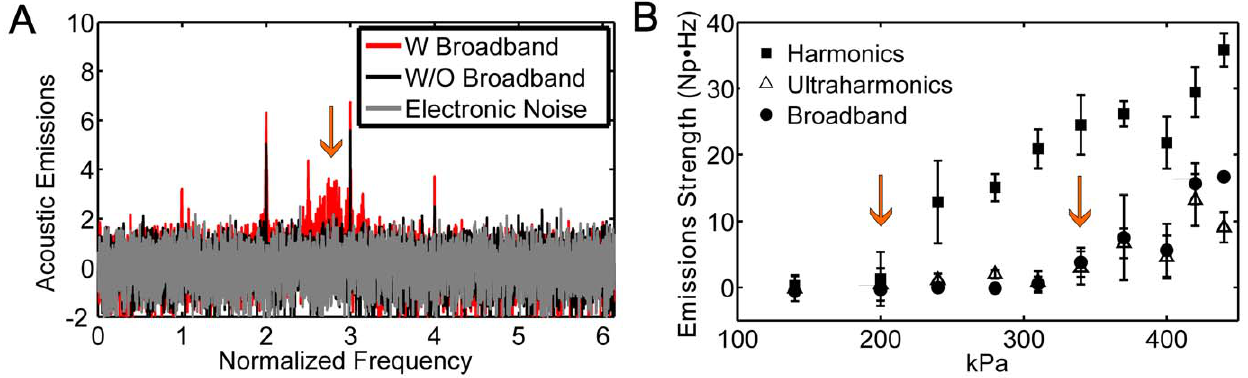
Figure 2. Acoustic emissions over a wide range of exposure levels. (A) Typical power spectra showing spectra with and without broadband emission. The emissions recorded during sonication with microbubbles were normalized to baseline data obtained during identical sonications without microbubbles according to Eq. 2. Wideband emission was observed as signal detected around 610 kHz (arrow), the resonant frequency of our receiving transducers. (B) Mean acoustic emissions signal ( 6 S.D.) as a function of the estimated pressure amplitude in the brain for harmonic, ultraharmonic and broadband emissions obtained in monkey # 1 during a sonication where bursts were applied sequentially at increasing pressure amplitudes. Between 200–400 kPa, the harmonic signal strength increased linearly as a function of pressure amplitude (R 2 =0.92). The harmonic signal increase per kPa was 0.14 6 0.01 Np ? Hz/kPa. The average signals from four bursts at each pressure amplitude are shown (mean 6 SD shown). The arrows indicate the lowest pressures where the harmonic and broadband signals were observed with an SNR greater than 3. Broadband and ultraharmonic emissions were only observed in these locations when the harmonic emissions were greater than 20 Np ? Hz.